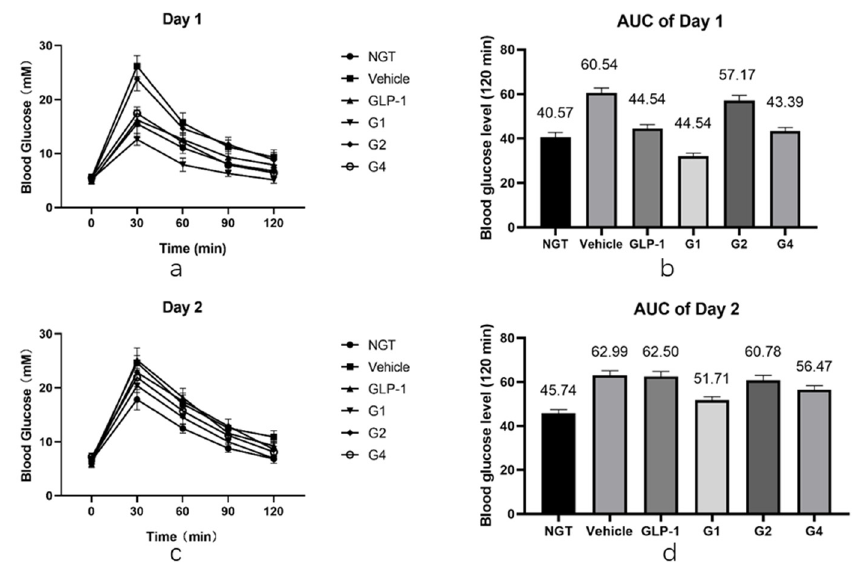
Figure 5. Glucose tolerance test of GLP-1RAs. ( a ) Blood glucose curve on the first day. ( b ) Blood glucose AUC on the first day. ( c ) Blood glucose curve on the second day. ( d ) Blood glucose AUC on the second day. See also Table A3: “The first day’s Glucose tolerance test results” and Table A4: “The second day’s Glucose tolerance test results”.